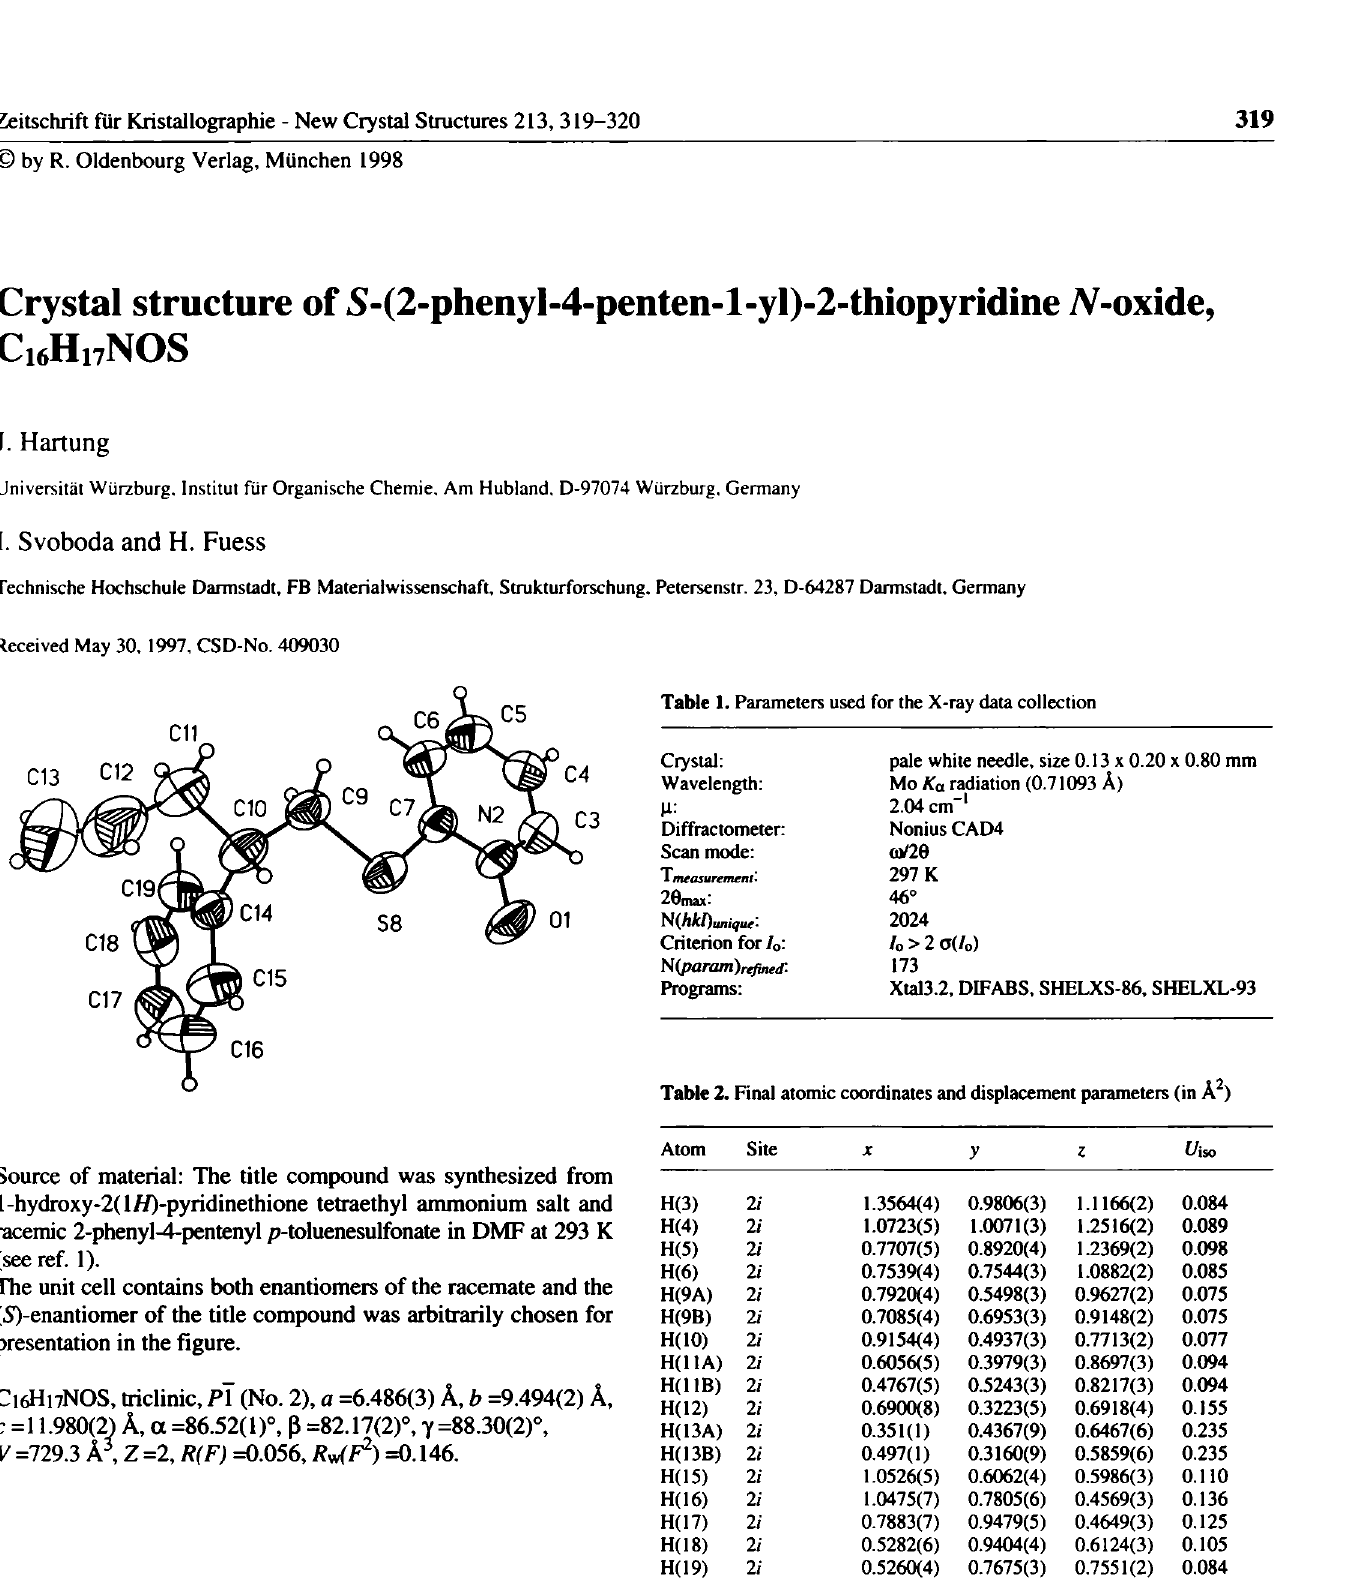
Table 3. Final atomic coordinates and displacement parameters (in Â^)